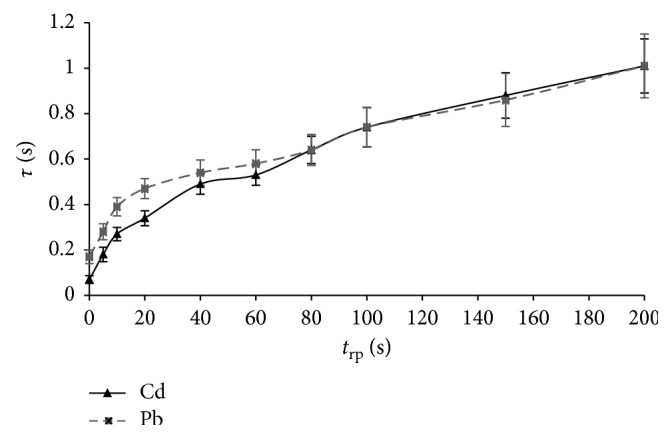
Influence of the rest period on the oxidation time (mean value ± 2 SD, n=5; cm = 40 μg/L; tdep = 60 s; Q = 11.0 ml/min).